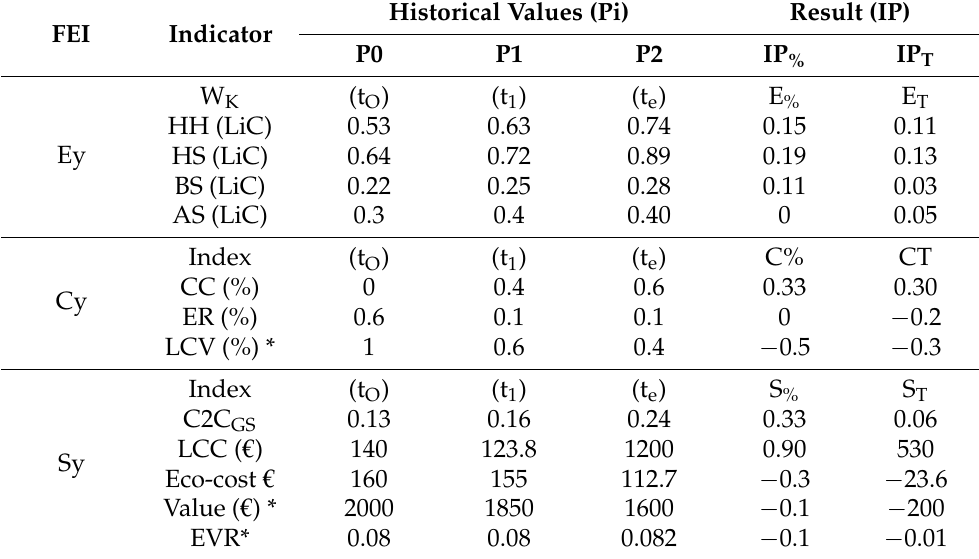
Table 6. Results of macro